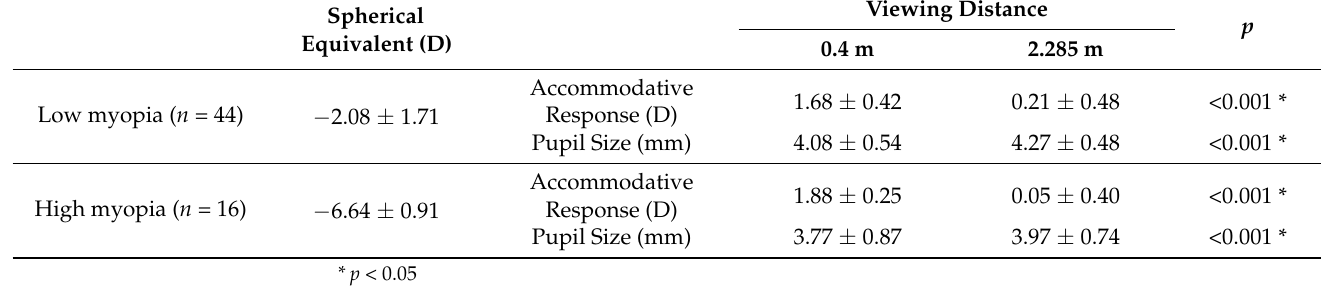
Table 2. Accommodative response and pupil size for the low and high myopia groups.